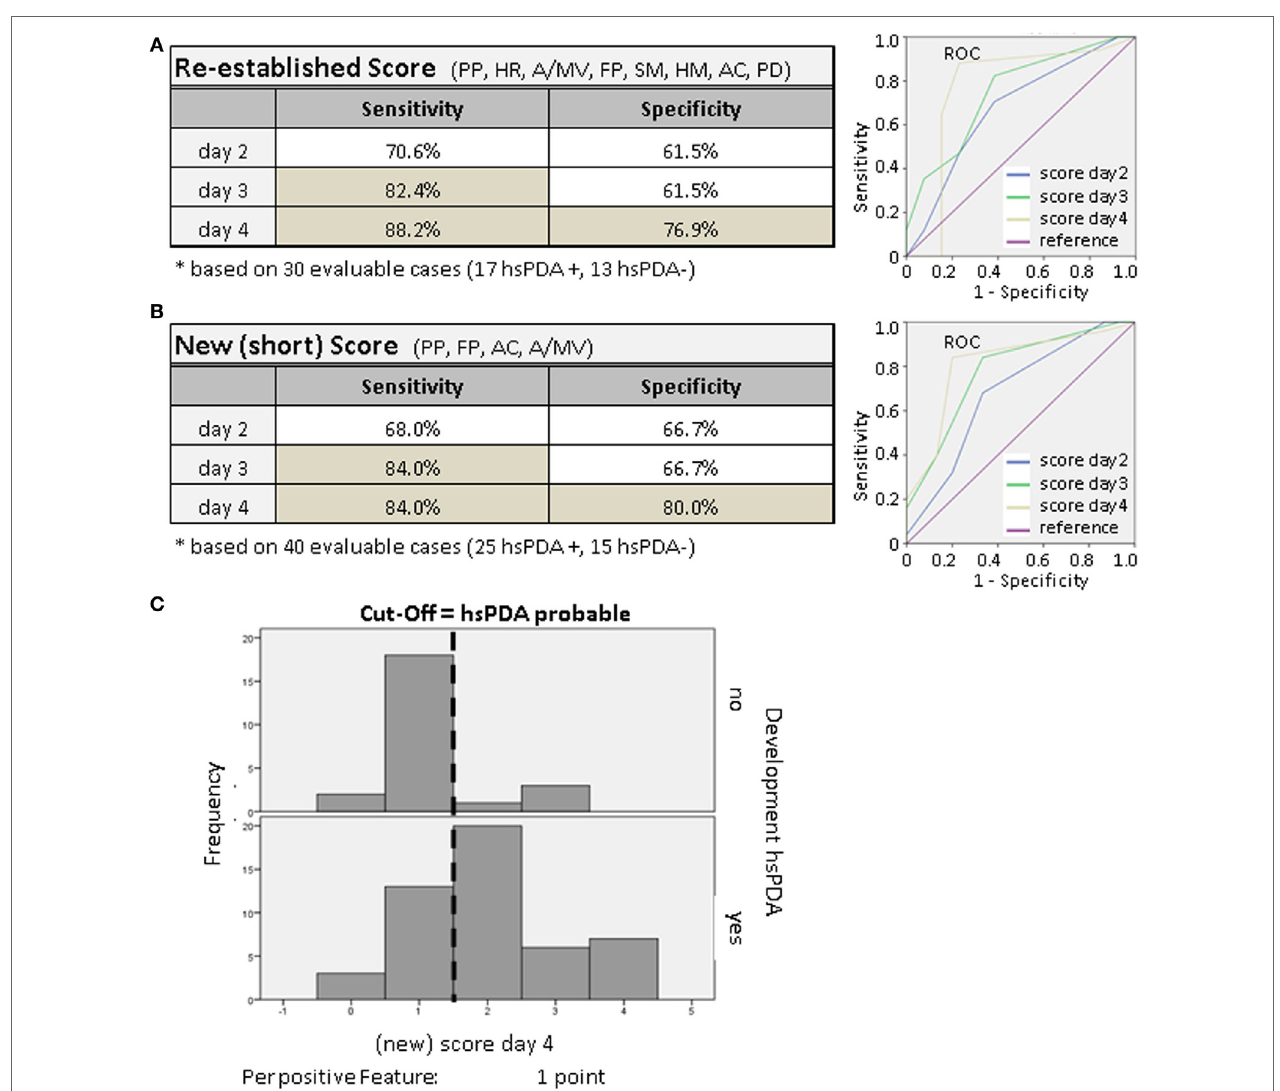
FigUre 2 | (a,B) Sensitivity and specificity of the clinical PDA score. Using multivariate logistic regression analysis (daily) and receiver operating characteristic (ROC) (29) curves, we compared the power of combinations of particular features and determined the sensitivity and specificity (dependent on the determined cutoff-level). The theoretical optimal cutoff-level was 1.5 points. (c) Screening of the validity of the clinical score. We tested to see if the score of ≥ 2 points was able to discriminate between the two groups with and without hsPDA. For the presence of a parameter we increased the number of points from 1 to 2 or 3. The frequency of the given points at day 4 of the score is shown as an example. On the upper part the infants without hsPDA are shown, those with hsPDA are shown on the lower part. Newborns with hsPDA usually reached a score of 2 or more